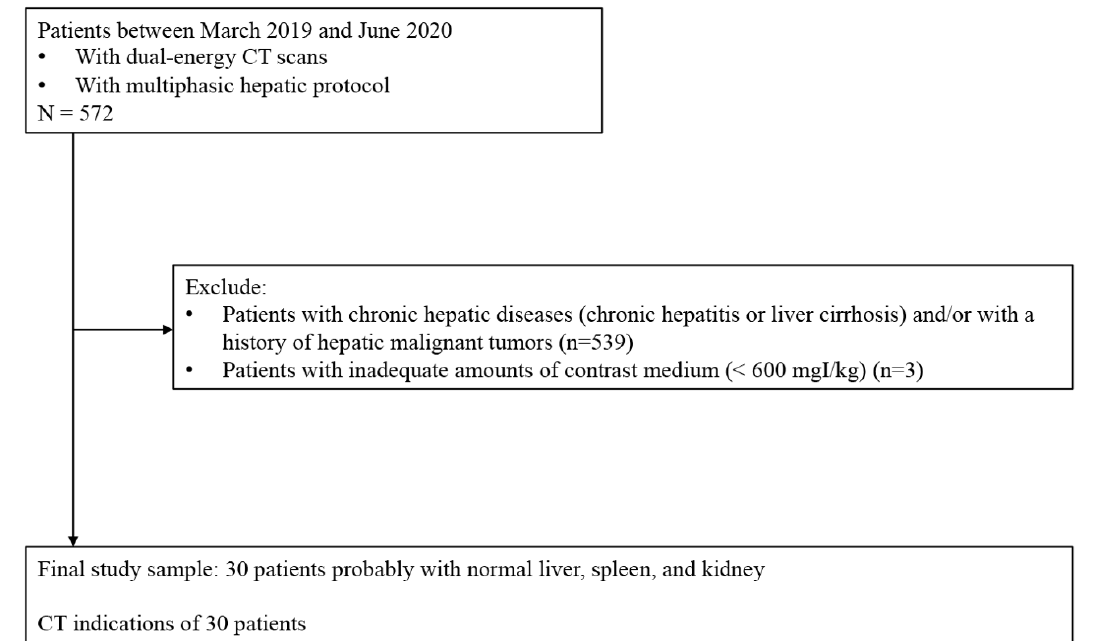
Figure 1. Flow diagram of the study sample.